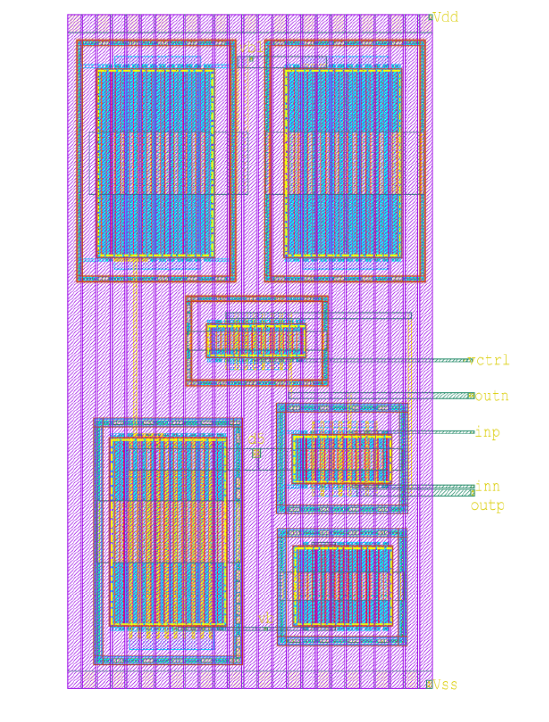
Figure 15. Layout of a CMOS differential stage implemented in Tanner from Mentor graphics using UMC 180 nm technology.